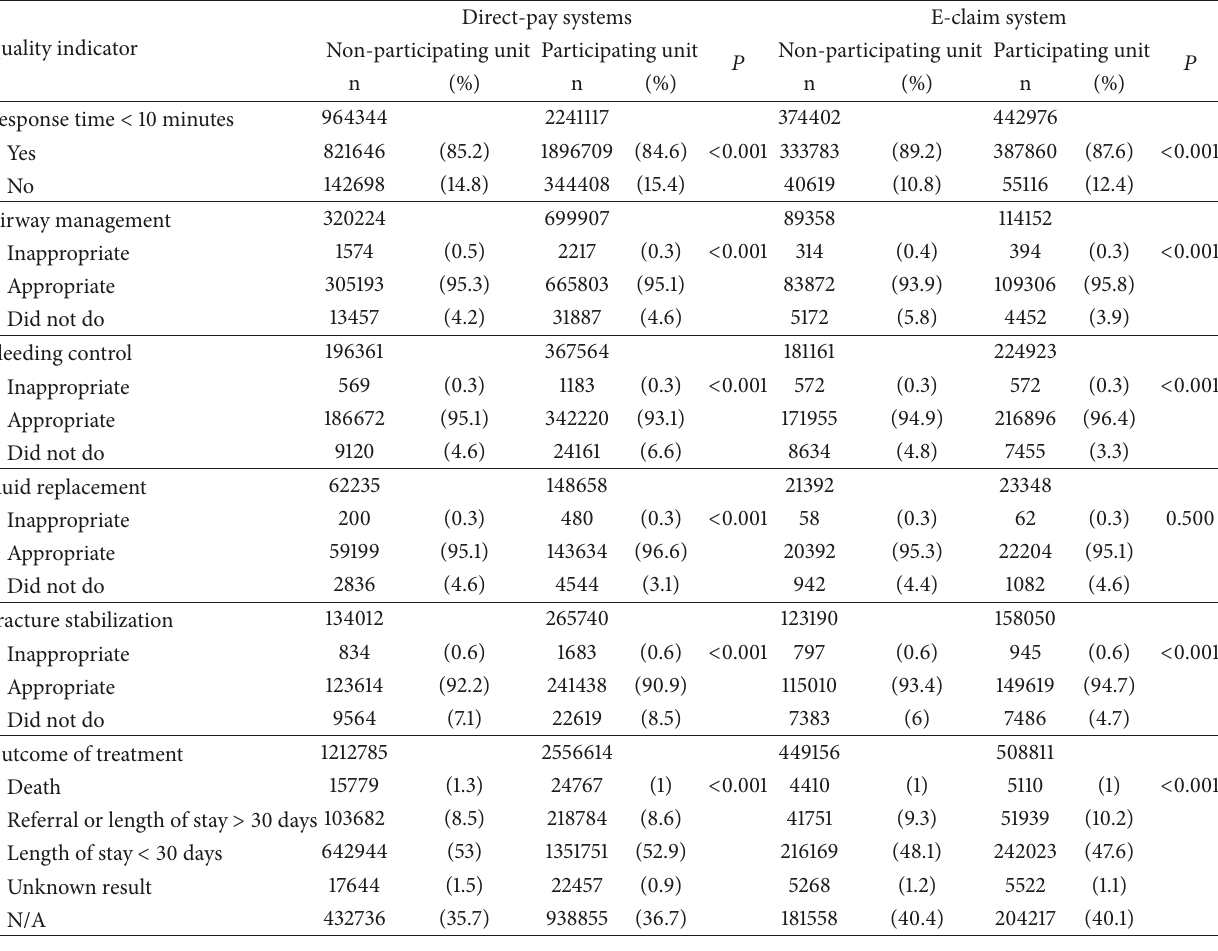
Table 6: Comparison of quality of care processes and patient outcomes between participating EMS units and nonparticipating EMS units under the direct-pay system and the E-claim system.